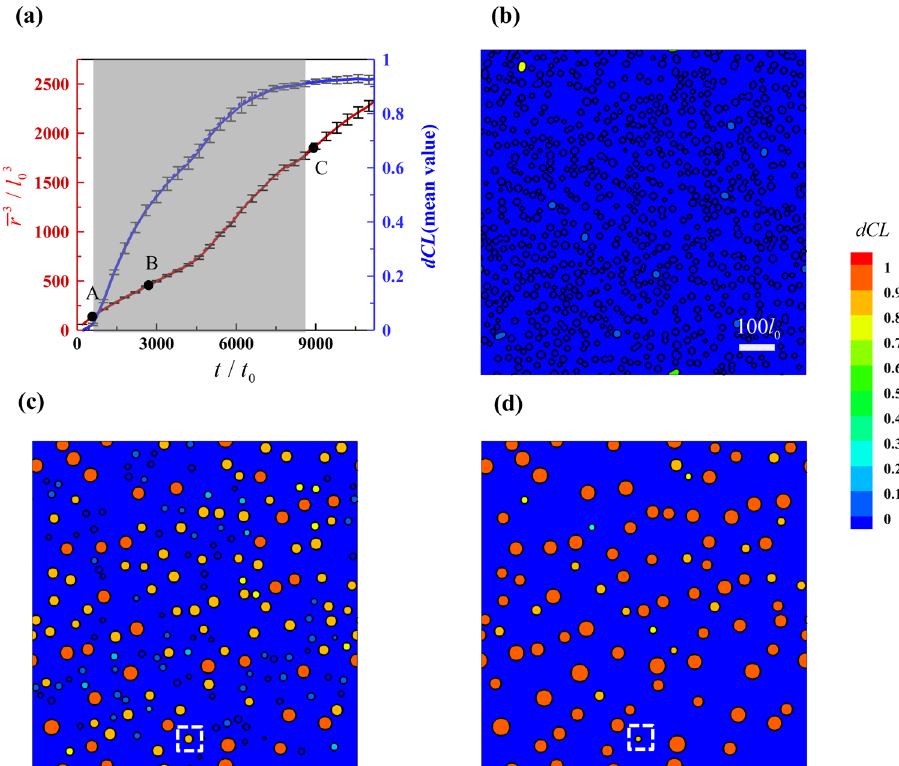
Fig. 4 Growth kinetics of Al 3 Sc and distribution of dCL during Ostwald ripening. a Growth kinetics with spontaneous loss of coherency. The red line represents the cube of mean particle radius and the blue line represents the average dCL. The shadow zone represents the main period of loss of coherency. The error bar for dCL is set to the standard deviation of average dCL from 10 simulation runs at the time. The error bar for r 3 is set to ð r þ s r Þ 3 (cid:2) r 3 (cid:7) 3 r 2 s r where s r is the standard error of r from the 10 runs. b – d Distribution of dCL (from 1 out of the 10 simulation runs), corresponding to A, B, and C points in a